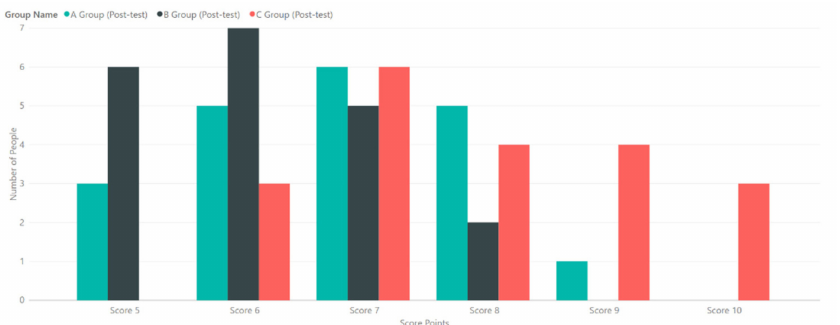
Figure 16. Individual score distribution in each group